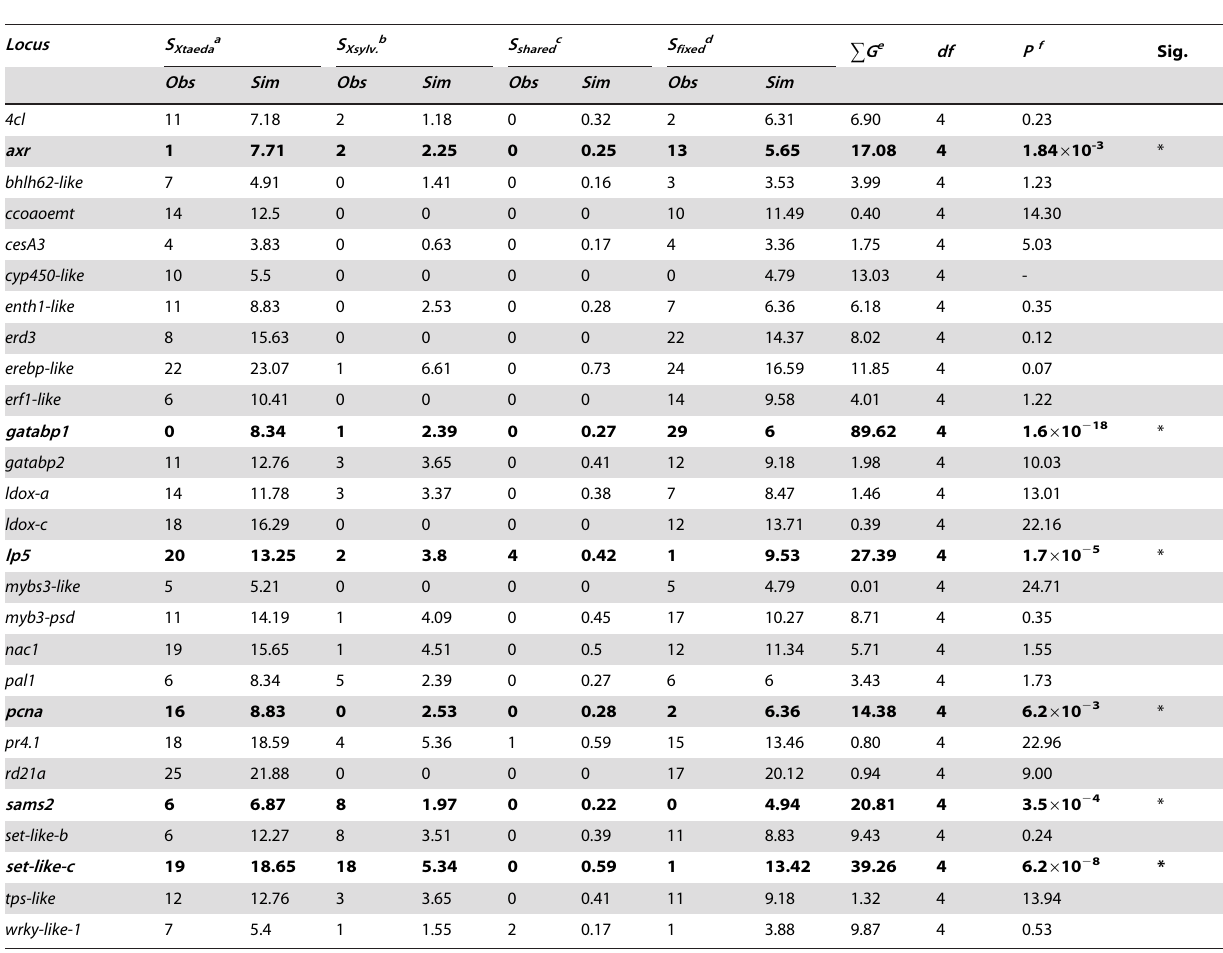
Table 2. Isolation model (IM) for Scots and loblolly pines.